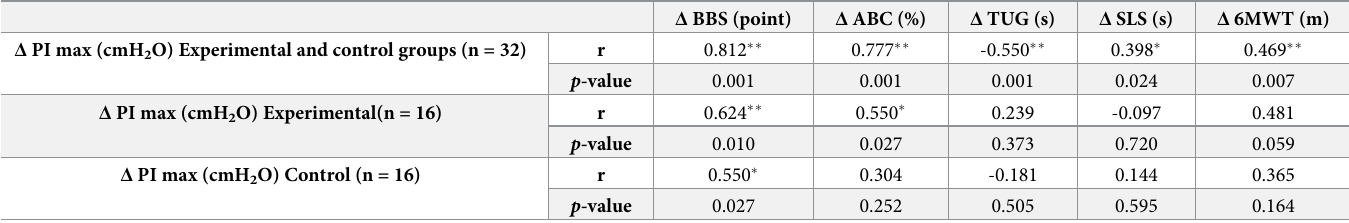
Table 4. Correlation analysis between inspiratory muscle strength and balance assessments.